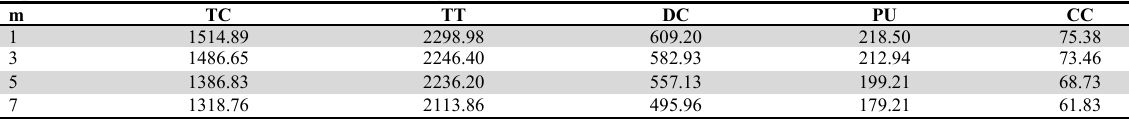
Experimental results on different number of depots